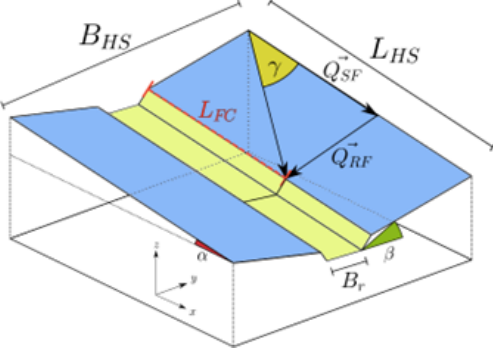
Figure 7. Representation of overland flow domains in Catflow–Rill as an open-book hillslope: sheet flow domain (blue area) and rill flow domain (yellow